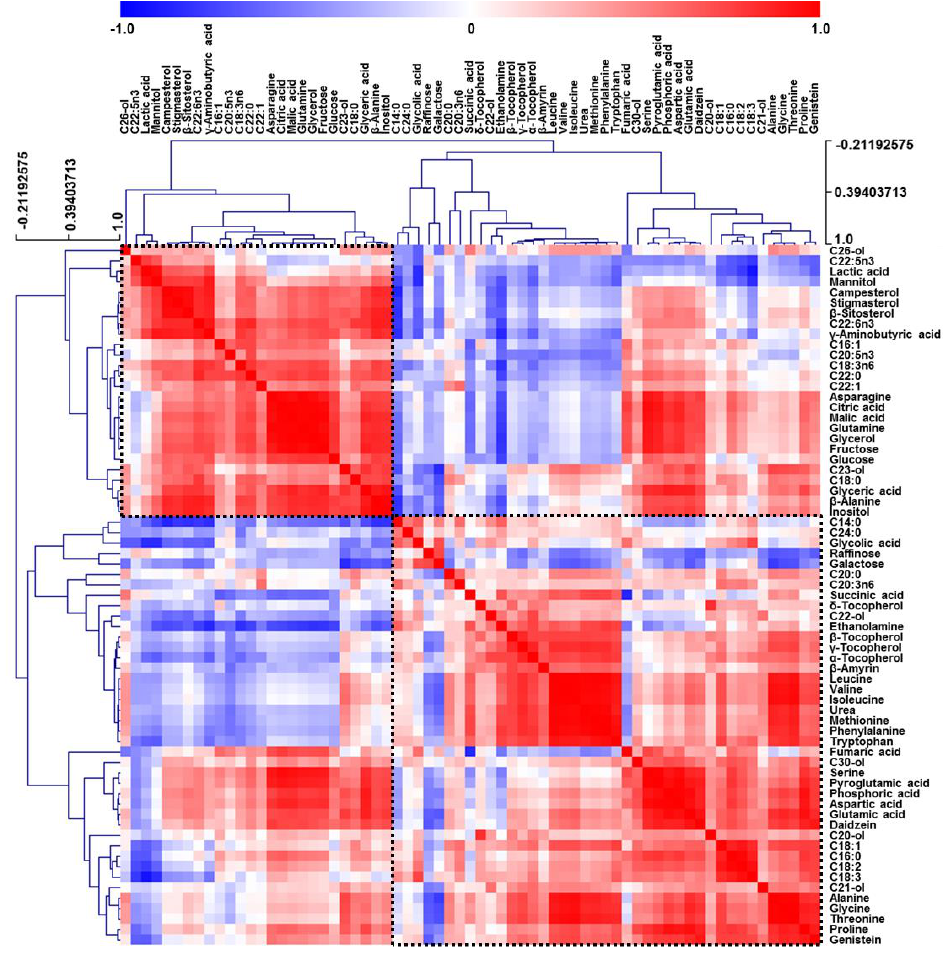
Figure 2. Correlation matrix obtained for hydrophilic metabolites, lipophilic metabolites, fatty acids, isoflavones, and raffinose extracted from soybeans. Each square indicates the Pearson’s correlation coefficient of a pair of compounds, with the value of this coefficient represented by the intensity of blue or red colors, as indicated on the color scale.